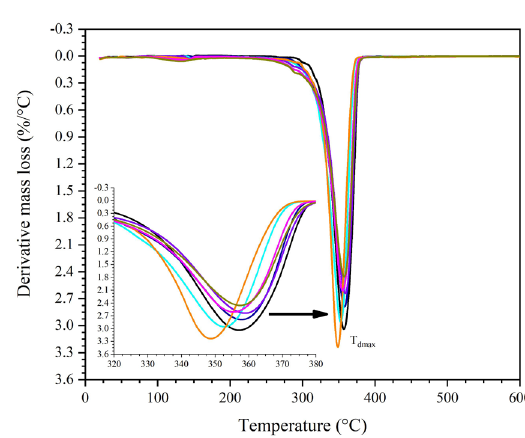
Figure 3. TGA curves of the produced films showing the two observed thermal events. The 1st event is evident only in films incorporated with OEO, being more pronounced with the 6% OEO content.